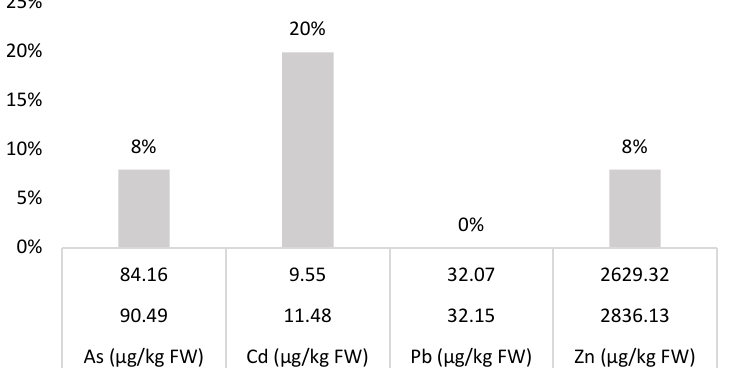
Figure 3. Differences between heavy metal concentrations in samples of fruit and vegetables washed with vinegar (5% and 10% acetic acid).